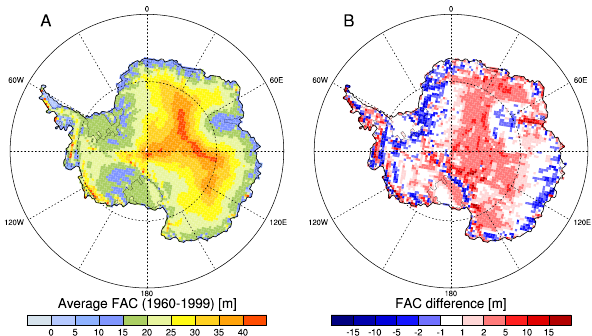
Figure 7. Average firn air content (FAC) for 1960–1999 (a) from the future FDM simulation, and the difference between (a) and av- erage FAC from the contemporary climate simulation (b) , interpo- lated from Fig. 1a to the same grid as in (a)